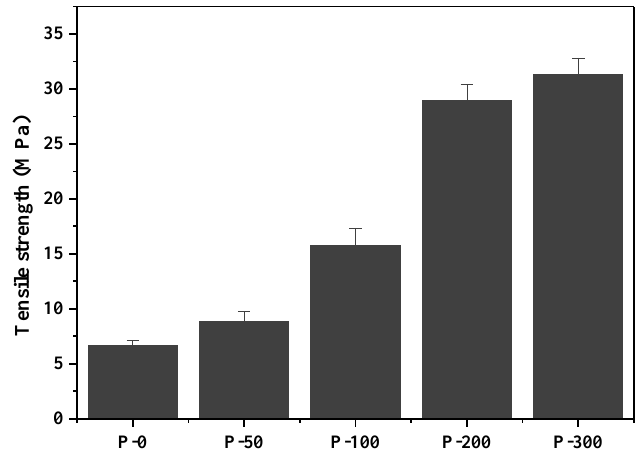
Figure 7. Tensile strengths for paper samples prepared using only the fiber samples of P-0, P-50, P-100, P-200, and P-300 fiber samples.